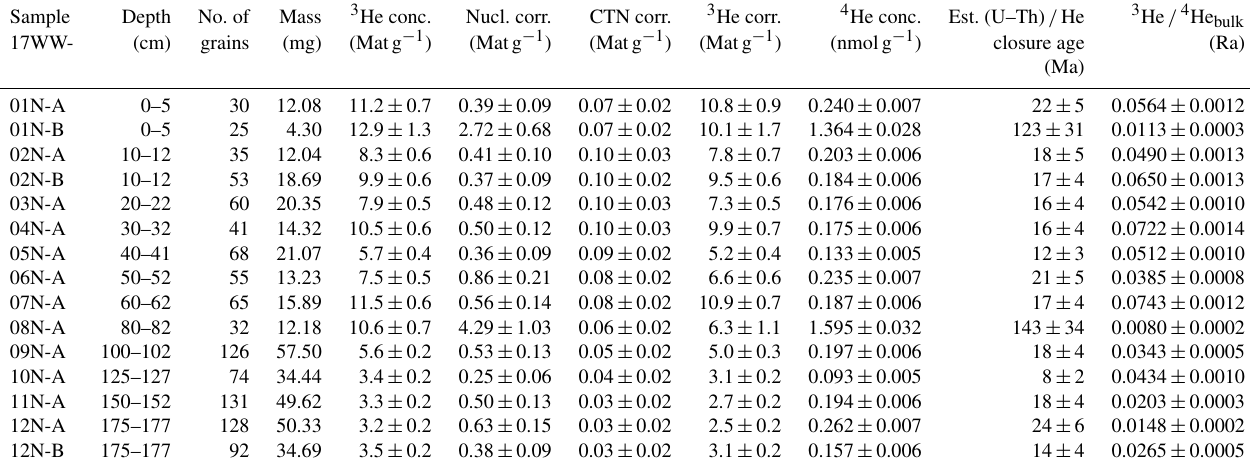
Table 4. 3 He and 4 He concentrations (conc.) in magnetite aliquots without inclusions, as confirmed by microCT. Corrections for nucleogenic (nucl.) and CTN-produced 3 He were subtracted from the bulk concentrations to yield corrected (corr.) 3 He concentrations. These corrections are based on the U, Th, and Li concentrations of the magnetite and matrix (see Table 1) and take into account ejection into and implantation from the matrix. The (U–Th) / He closure ages were estimated based on average U and Th concentrations and are used to calculate the individual nucleogenic 3 He corrections for each sample. All uncertainties are given as 1 σ .